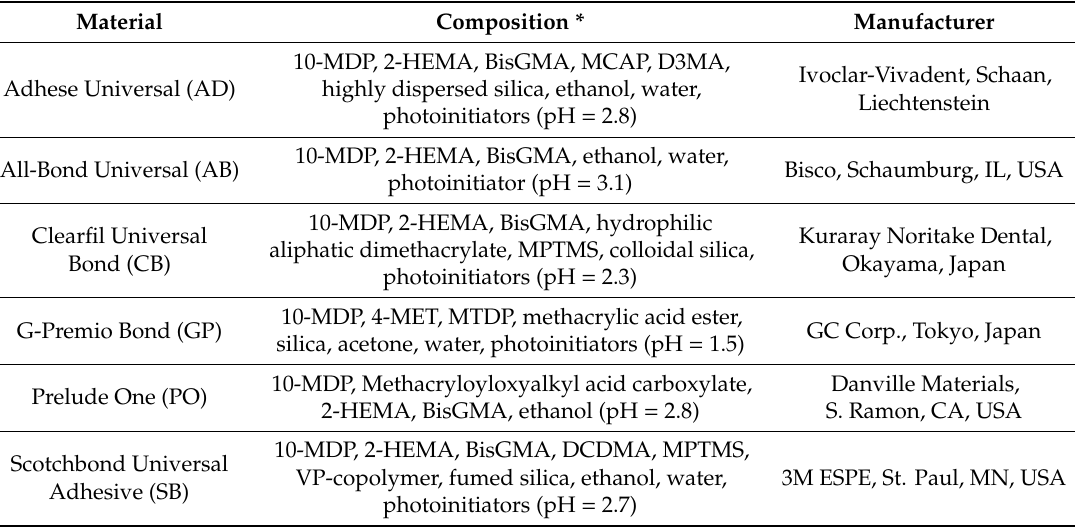
Table 1. The composition of the universal adhesives tested in the